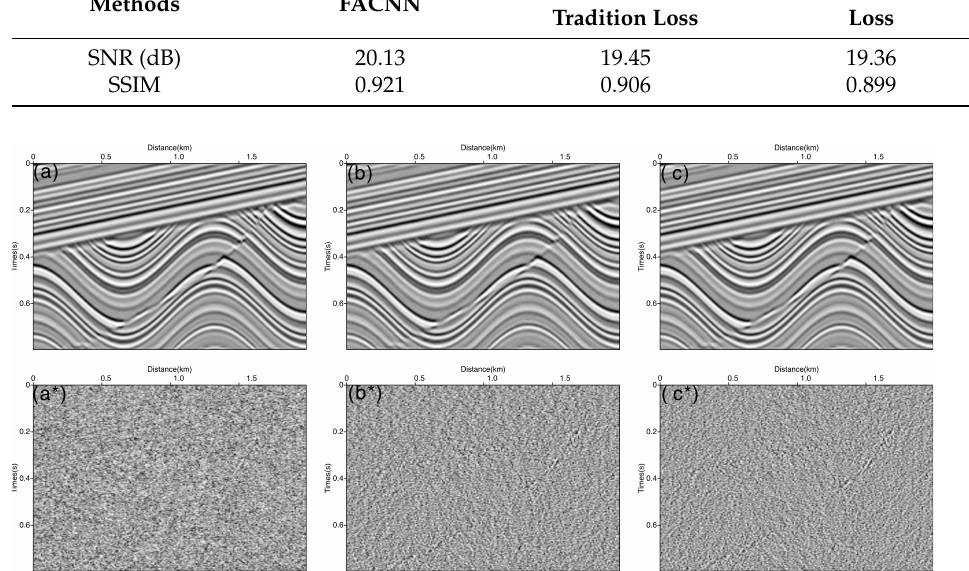
Figure 7. ( a , a* ) FACNN denoised result and its removed noise. ( b , b* ) Attention-CNN denoised result and removed noise, with tradition loss function. ( c , c* ) U-Net denoised result and removed noise, with proposed loss